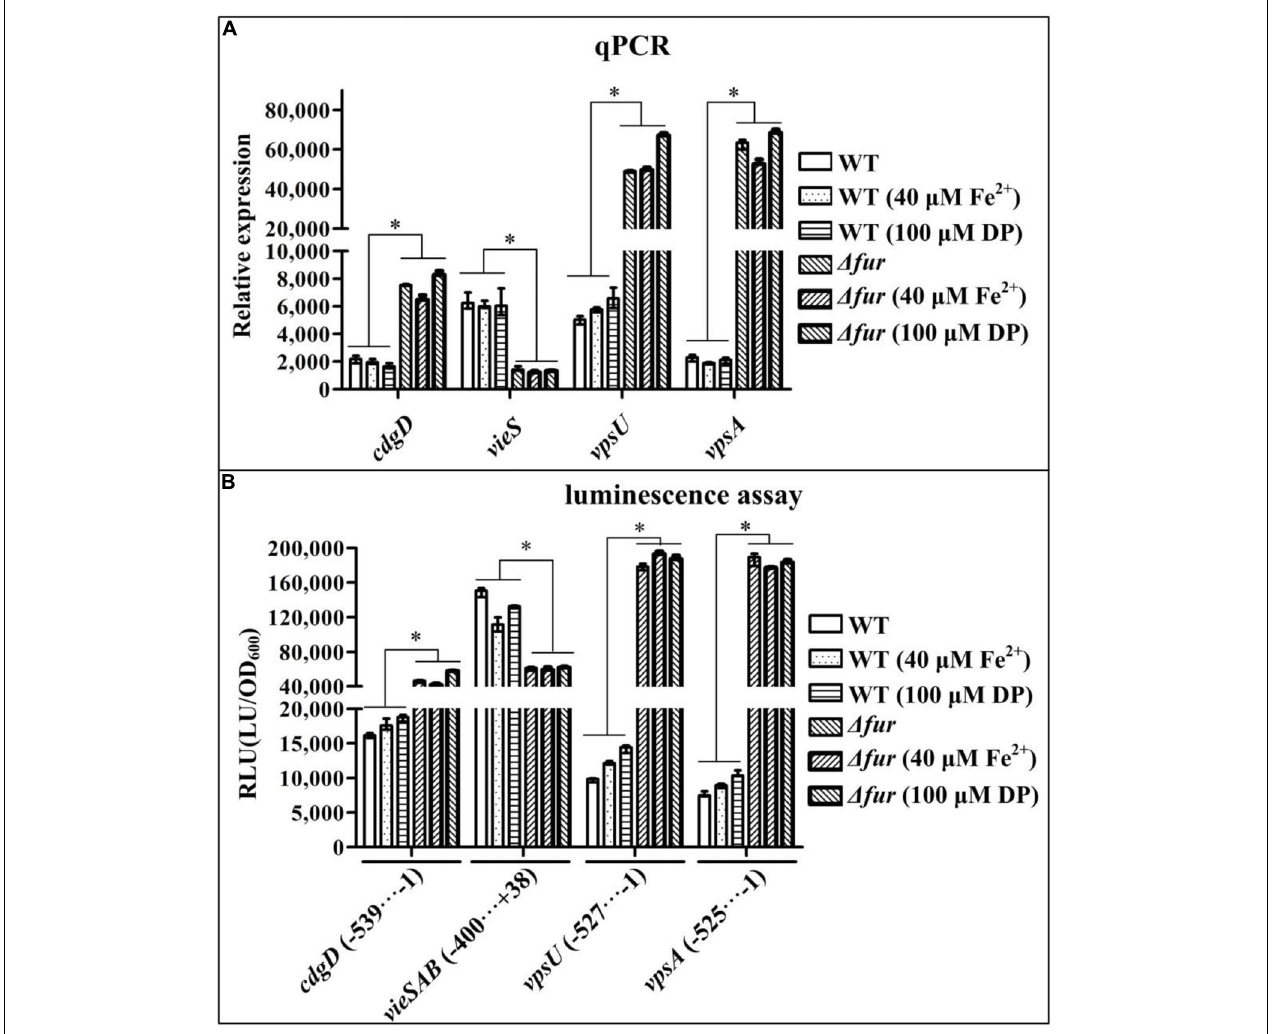
FIGURE 3 | Fur regulates the expression of vieSAB , cdgD , vpsA , and vpsU . Bacterial cells were harvested at an OD 600 value of approximately 0.6. Statistical differences between wild type (WT) and (cid:49) fur ( ∗ at P < 0.01) were determined by a two-way ANOVA with Tukey’s post hoc . (A) Quantitative PCR (qPCR) assay was employed to determine relative mRNA levels for each target gene in (cid:49) fur and WT using a standard curve of recA (reference gene) expression for each RNA preparation. (B) For the luminescence assay, the entire promoter DNA region of each target gene was cloned into a pBBRlux vector, and then introduced into (cid:49) fur and WT, to determine the luminescence activity for each strain using an Infinite R (cid:13) 200 Pro NanoQuant. The lux activity (RLU) was calculated as light units/OD 600 . The minus and positive numbers represented the nucleotide positions upstream and downstream of the translation start site of each target gene.